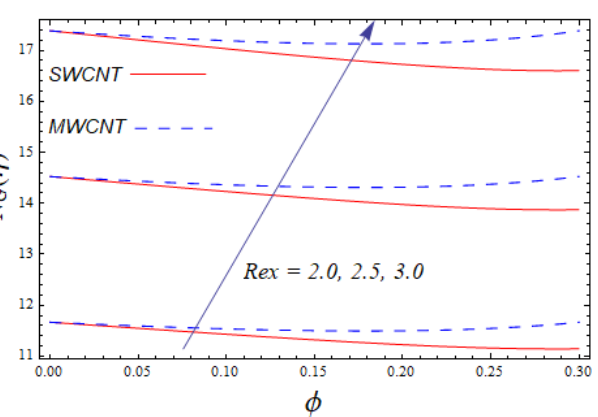
Coatings 2019 , 9 , x FOR PEER REVIEW Figure 15. The illustration of M versus N G (η). Figure 15. The illustration of M versus N G ( η ).